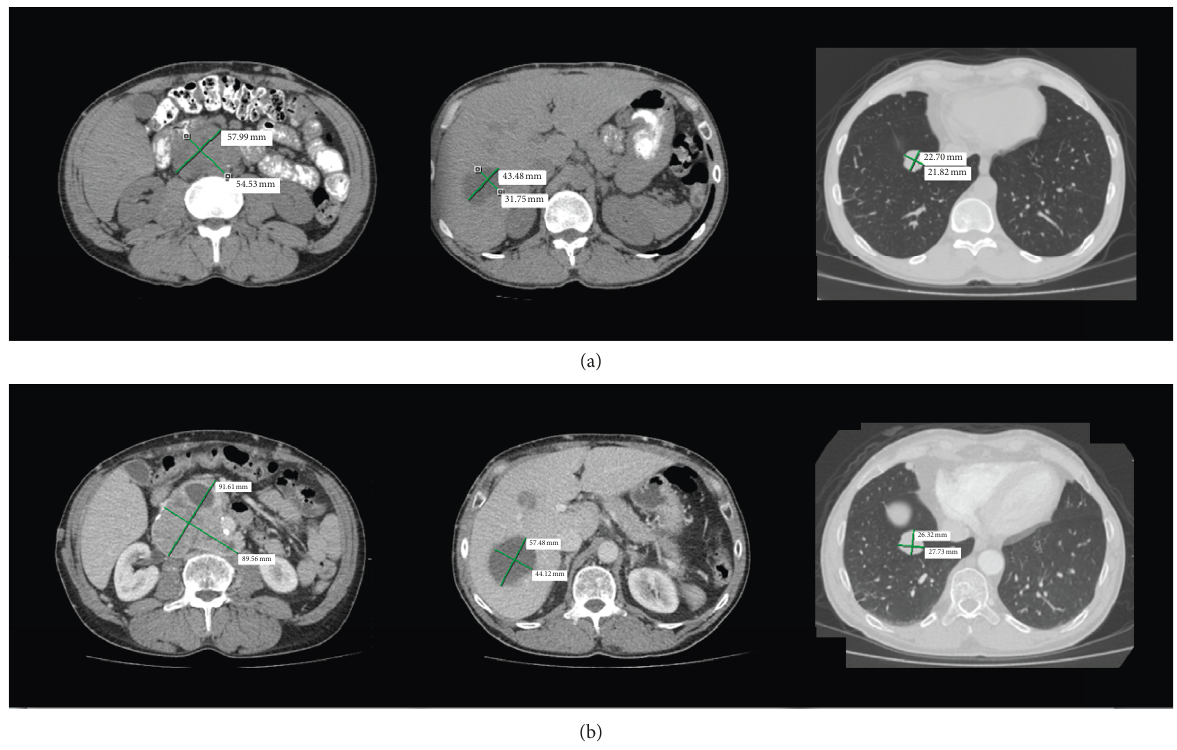
Figure 1: Original imaging from day of diagnosis are not available; however, images 4years after diagnosis are displayed in (a). The left image demonstrates the primary pheochromocytoma in the Organ of Zuckerkandl. The middle image demonstrates one of the metastatic liver lesions, and the far-right image demonstrates a metastatic lung lesion with their corresponding measurements. Most recent imaging, over 15 years since diagnosis, demonstrates these same lesions with their respective measurements in